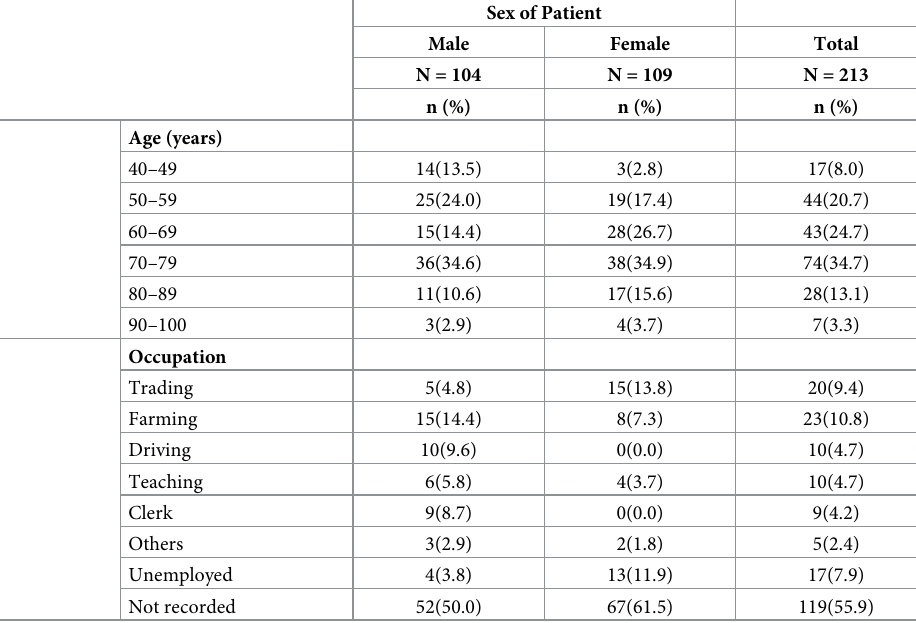
Table 1. Socio-demographic characteristics of the patients